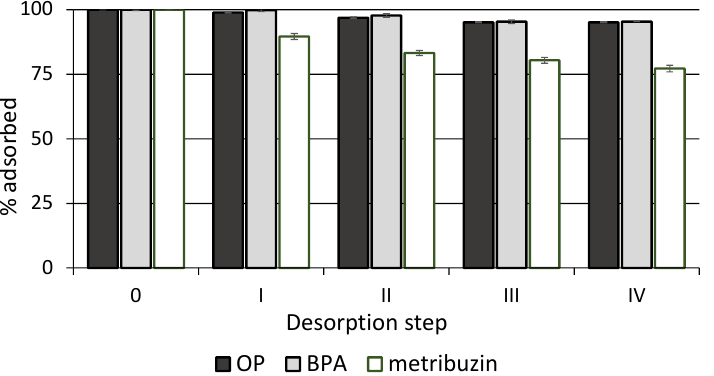
Figure 9. Percentage of compound that remains adsorbed on biochar after each desorption step. Standard error is reported as vertical bar on each point (n = 3).